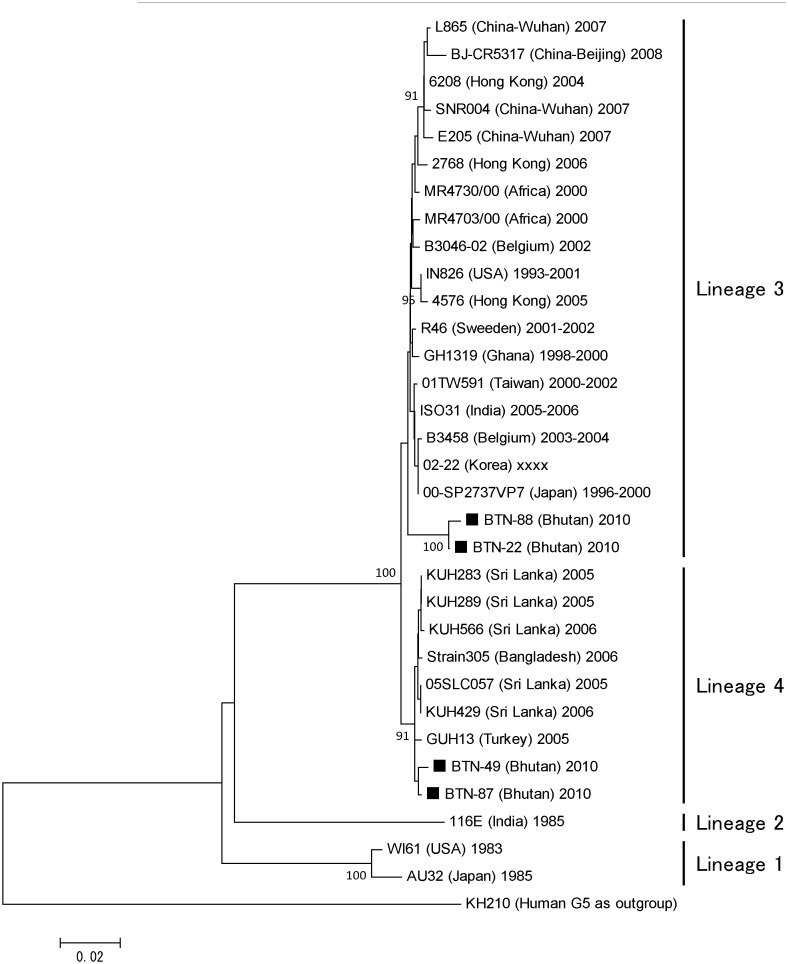
Phylogenetic tree constructed base on the deduced amino acid sequences of the VP7 genes of G9 strains.Bhutanese strains are indicated by black squares, which are followed by the strain numbers. Human rotavirus KH210 (G5) was used as an outgroup. The numbers adjacent to nodes represent the bootstrap values; values <70% are not shown. The scale bar shows the genetic distance, which is expressed as amino acid substitutions per site. The DNA Data Bank of Japan/European Molecular Biology Laboratory/GenBank accessions numbers are: AB905463 (rotavirus strain BTN-22), AB905464 (BTN-49), AB905465 (BTN-87), and AB905466 (BTN-88).